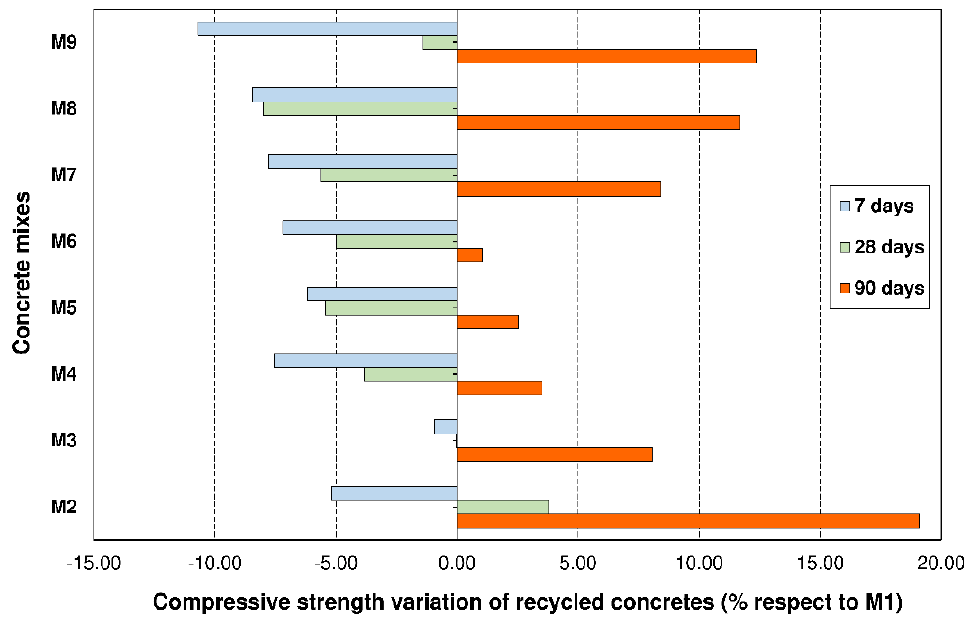
Figure 6. Compressive strength variation of recycled concretes (M2–M9) compared with conventional concrete (M1).